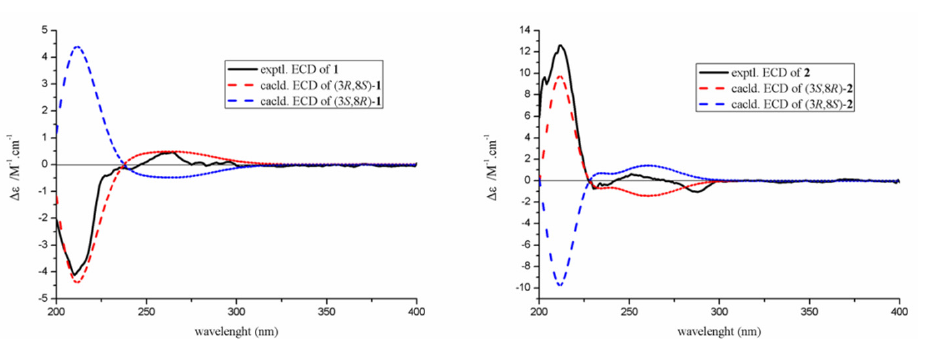
Figure 4. Experimental and calculated ECD spectra of compounds 1 and 2 .